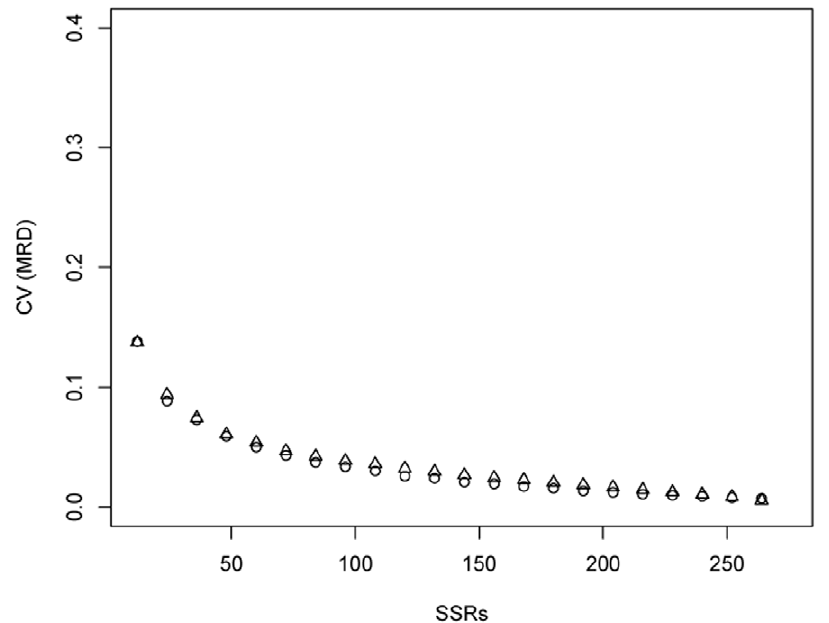
Figure 6. Coefficient of variation (CV) of modified Roger ’ s distance (MRD) among all pairs of varieties assessed by random (triangles) and stratified (circles) resampling with 100 replications. For details see Materials and Methods.